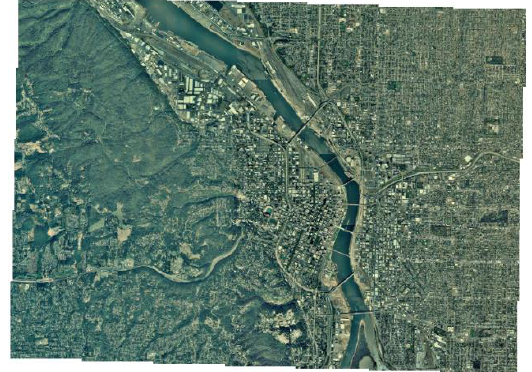
Fig.3.3 Color balance result: 2 nd Order Polynomial Target Model.